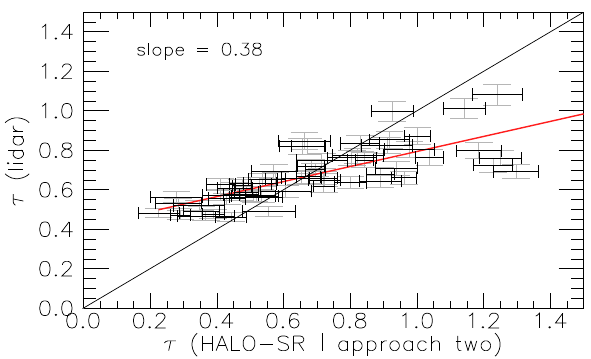
Fig. 16. Comparison of τ retrieved by the HSRL and HALO-SR based surface albedo approach 2 for 4 November 2010. For the calculations a parametrization simulating a mixture of ice crystal shapes is used.